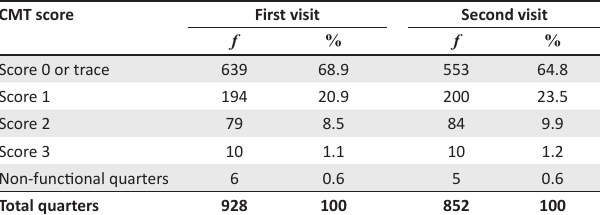
TABLE 1: Distribution of quarter California Mastitis Test scores for both the first and second farm visits from Mukurwe-ini and Nakuru Districts, Kenya, June 2010 to August 2010.